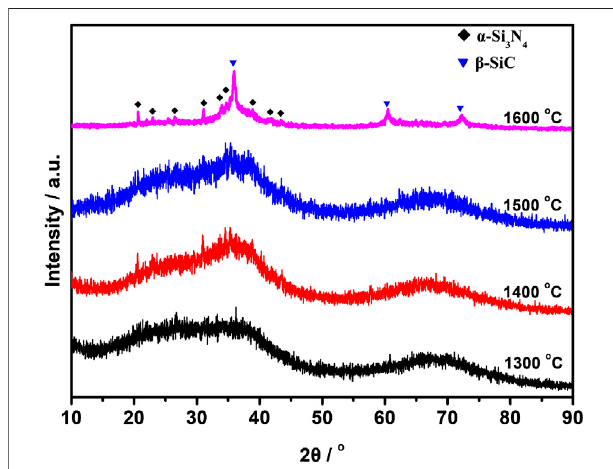
FIGURE 2 | XRD patterns of SiCN fi bers after annealing at different temperatures.